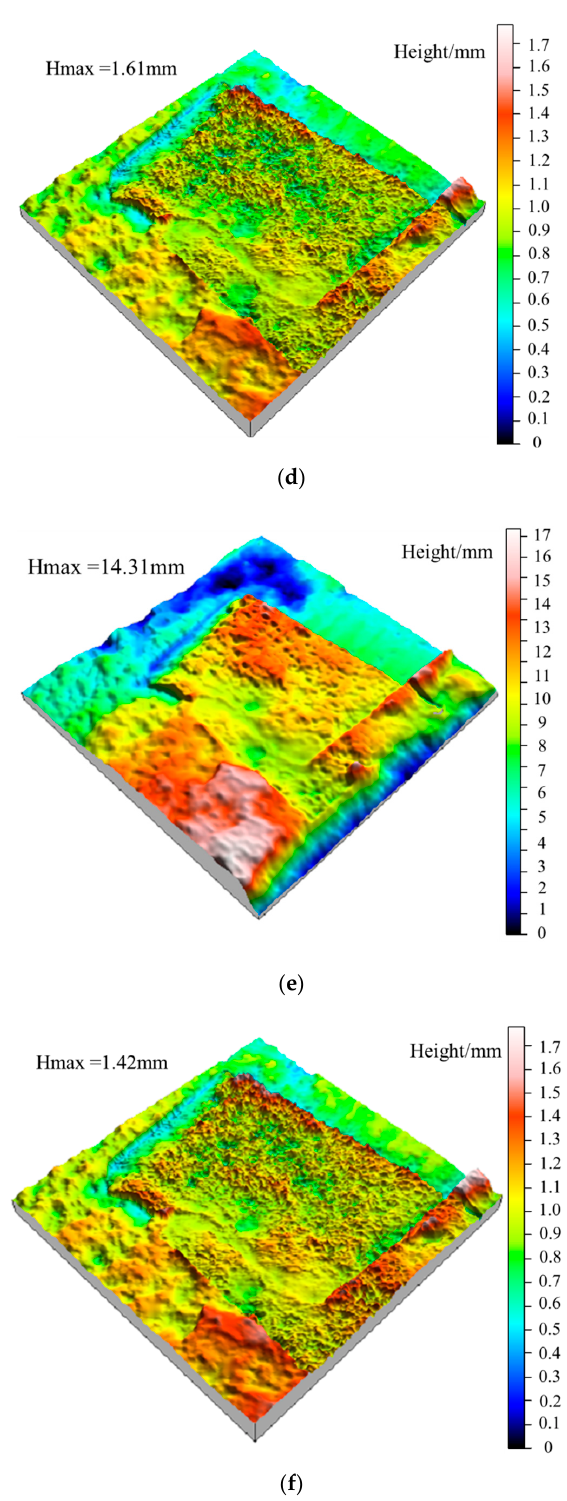
Figure 10. Three-dimensional topography of surface waviness and unevenness after shearing of the unfrozen specimen. ( a ) The waviness morphology after the first shear experiment. ( b ) The roughness morphology after the first shear experiment. ( c ) The waviness morphology after the second shear experiment. ( d ) The roughness morphology after the second shear experiment. ( e ) The waviness morphology after the third shear experiment. ( f ) The roughness morphology after the third shear